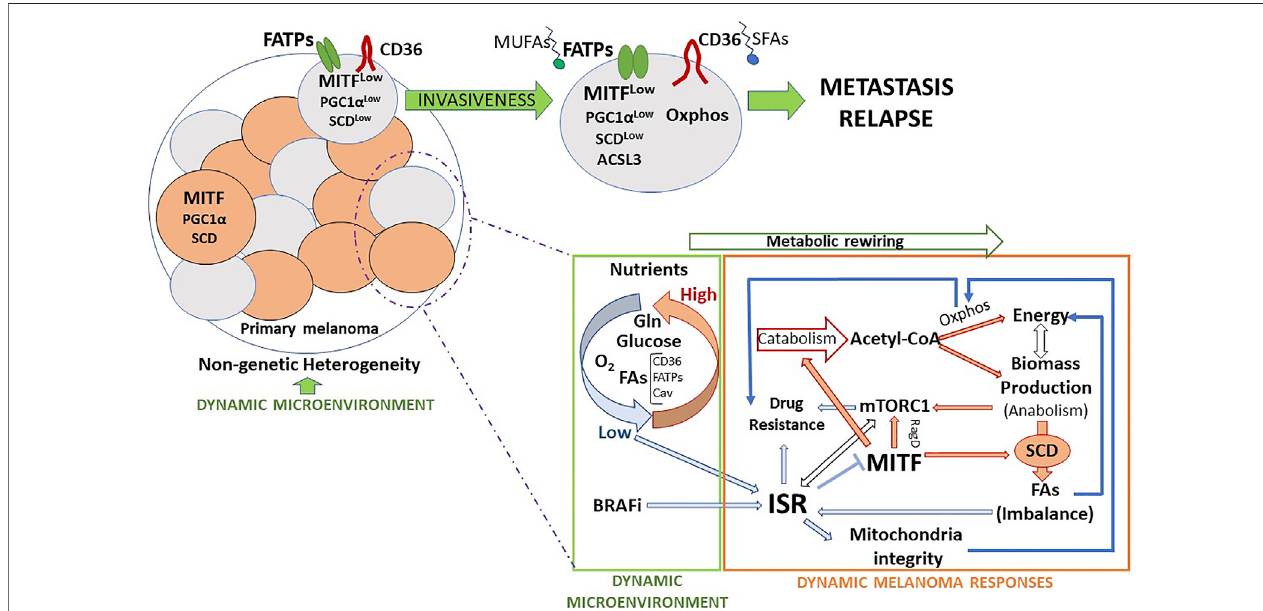
FIGURE 2 | Metabolic features and routes towards invasion and metastasis. Melanomas, subjected to microenvironment-driven non-genetic heterogeneity, are composed of several cell subsets, which express different levels of MITF and display speci fi c metabolic features that provide a distinct identity. Eventually, as a consequenceofsuchareversibleidentityandasa fi rststepofthemetastaticprocess,somecellsacquireinvasivecapacityandescapefromtheprimarytumor.Migrating cells can adapt to the extrinsic insults affecting them. FA metabolism may provide melanoma cells with survival advantages that facilitate the metastatic process. The main dynamic microenvironmental cues that lead to melanoma phenotypic changes are nutrients, drugs, and in fl ammatory signals (not represented in the fi gure). Melanoma cells respond to changes in these parameters adapting their metabolism, at least in part, through the activation of the ISR. The ISR works in melanoma as a microenvironment-sensing pathway that modulates cell phenotype and metabolic activity, alone or in coordination with other key nutrient sensing pathways, like mTORC1.